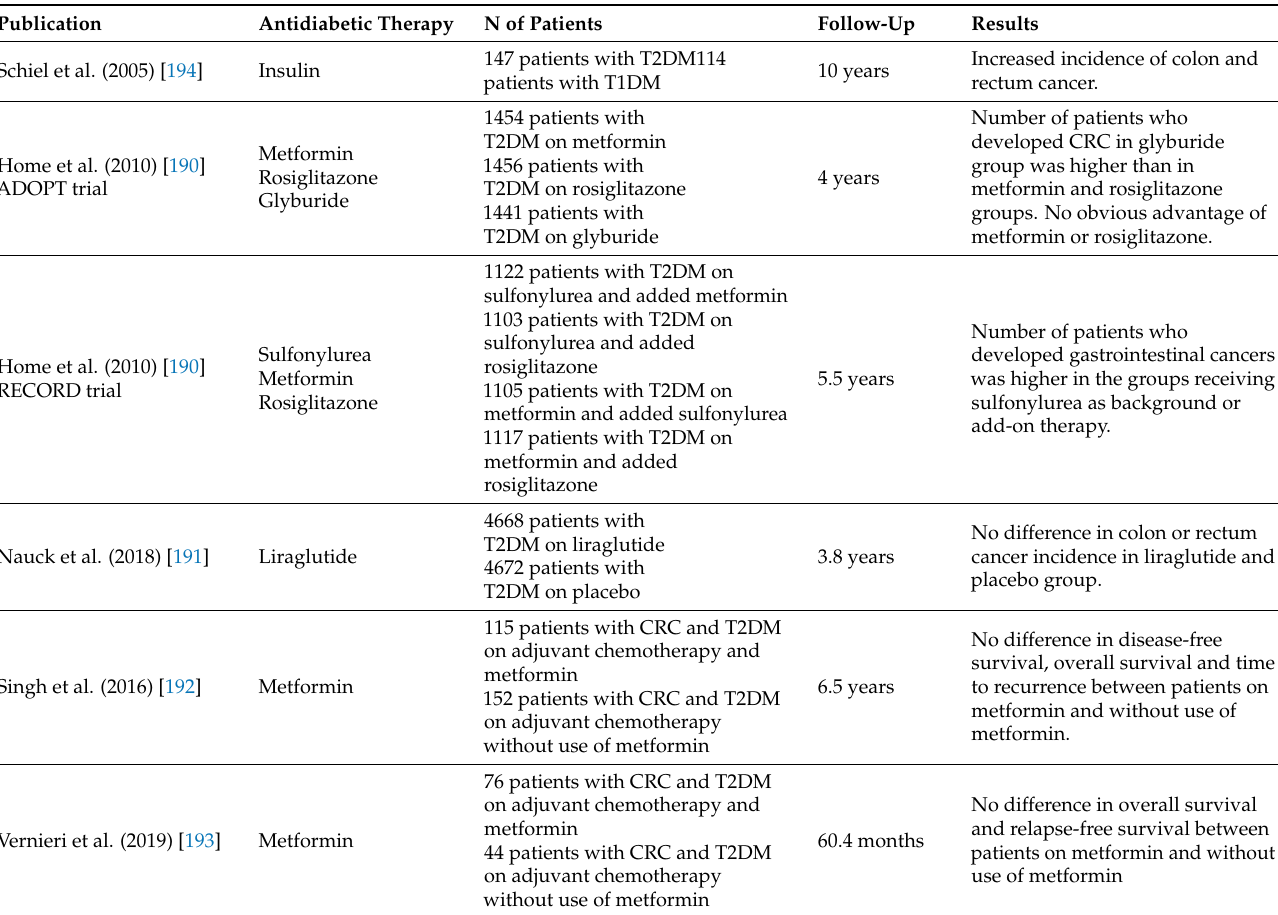
Table 1. Clinical trials investigating the impact of antidiabetic therapy in T2DM patients on CRC risk or survival of patients with